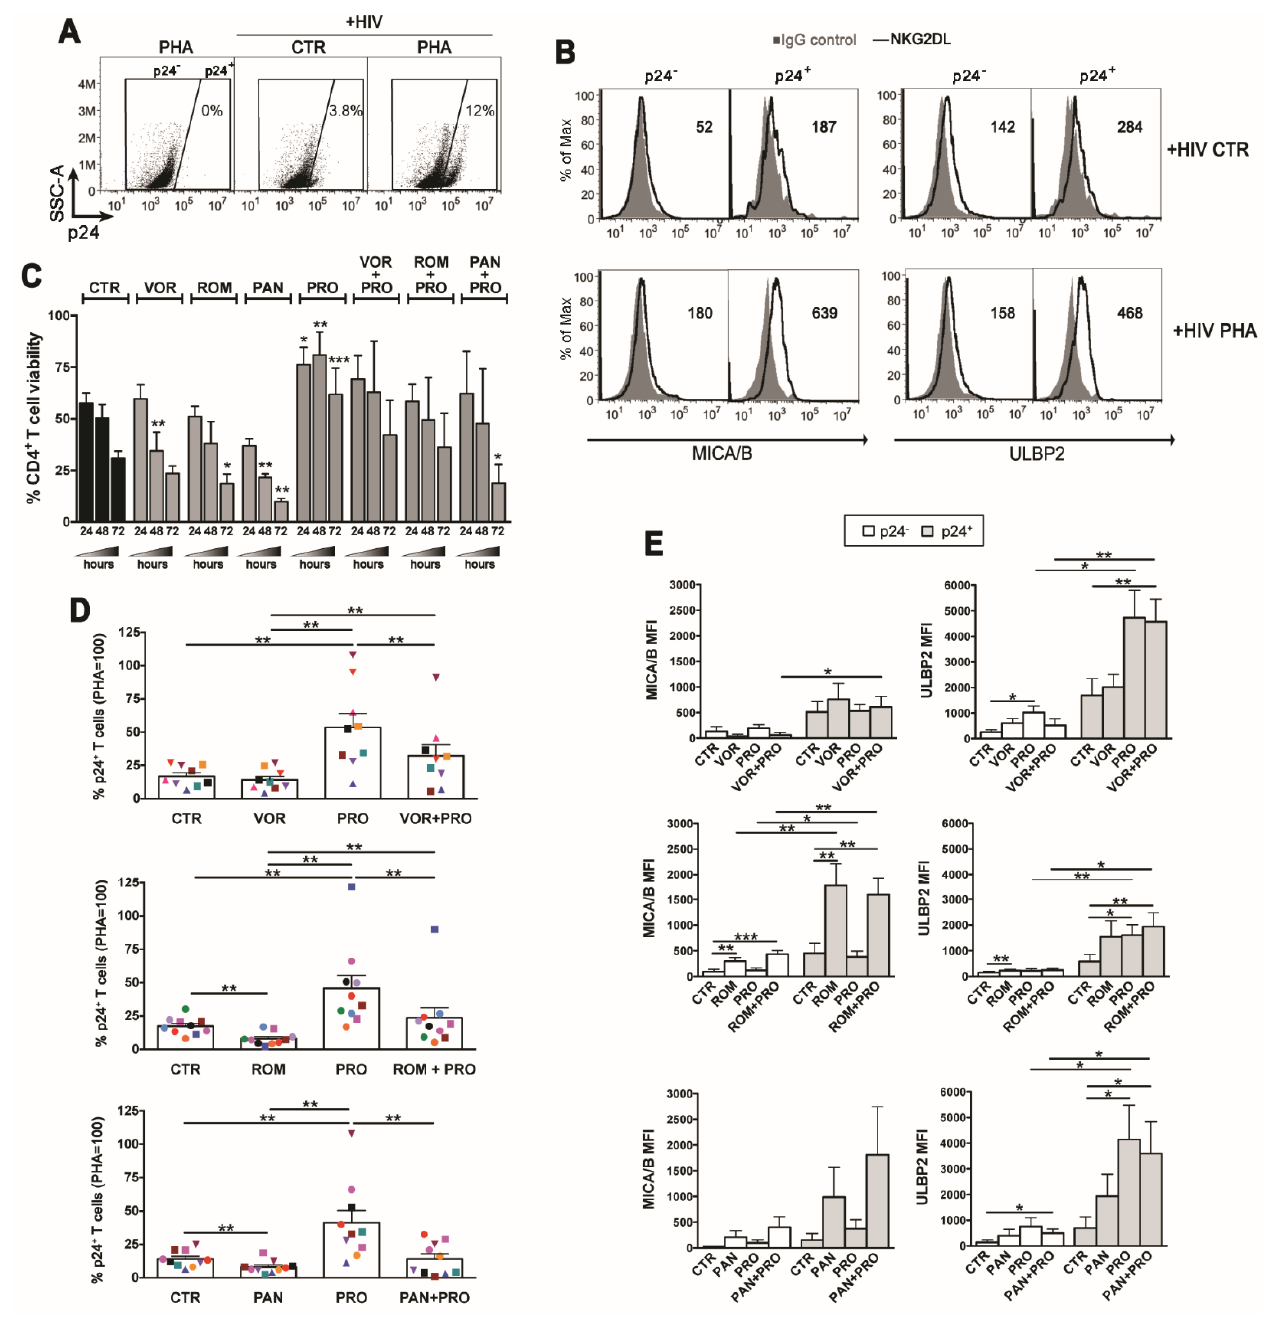
Figure 3. Impact of the HDACi/PRO combinations in viability, viral reactivation, and NKG2DLs expression in latently HIV-infected CD4 + T cells. HIV latency was established in CD4 + T cells freshly isolated from healthy donors (see Materials and Methods), then cells were exposed to LRAs for 3 days prior 2-color flow cytometry analysis of cell-surface MICA/B and ULBP2 expression in p24 - and p24 + cells. ( A ) Representative dot plots show the frequency of p24 + cells in control (CTR) and PHA-stimulated cultures gated by setting non-infected PHA-stimulated cells at 0%. ( B ) Histograms show MICA/B and ULBP2 fluorescence (solid line) in gated p24 - and p24 + cell populations measured in representative control and PHA-stimulated cell samples. Signals obtained with control IgG (filled histograms) and the ligand-specific MFI value, subtracted of the MFI value of isotype control, are shown. ( C – E ) Cells of several donors were cultivated in absence of stimuli (CTR) or with VOR (334 nM), ROM (10 nM), PAN (20 nM), PRO (1 µM), or combinations of each HDACi with PRO. ( C ) T cell viability (mean ± SEM, n = 3) was examined at 24, 48, and 72 h by LIVE/DEAD staining. ( D ) The frequency of p24 + cells harboring reactivated virus was evaluated for all conditions in 9–10 independent experiments (each donor is represented with distinct symbol) and expressed relatively to PHA set at 100%. ( E ) The cell-surface MICA/B and ULBP2 expression was analyzed on p24 - and p24 + cells as described in ( B ) in 5–8 independent experiments. Bars represent mean ± SEM.